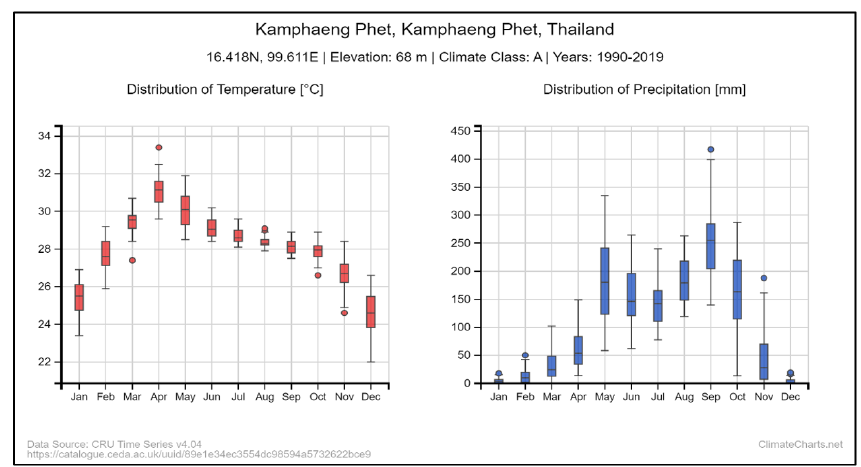
Figure 1. Annual temperatures and annual rainfall in Kamphaeng Phet Province